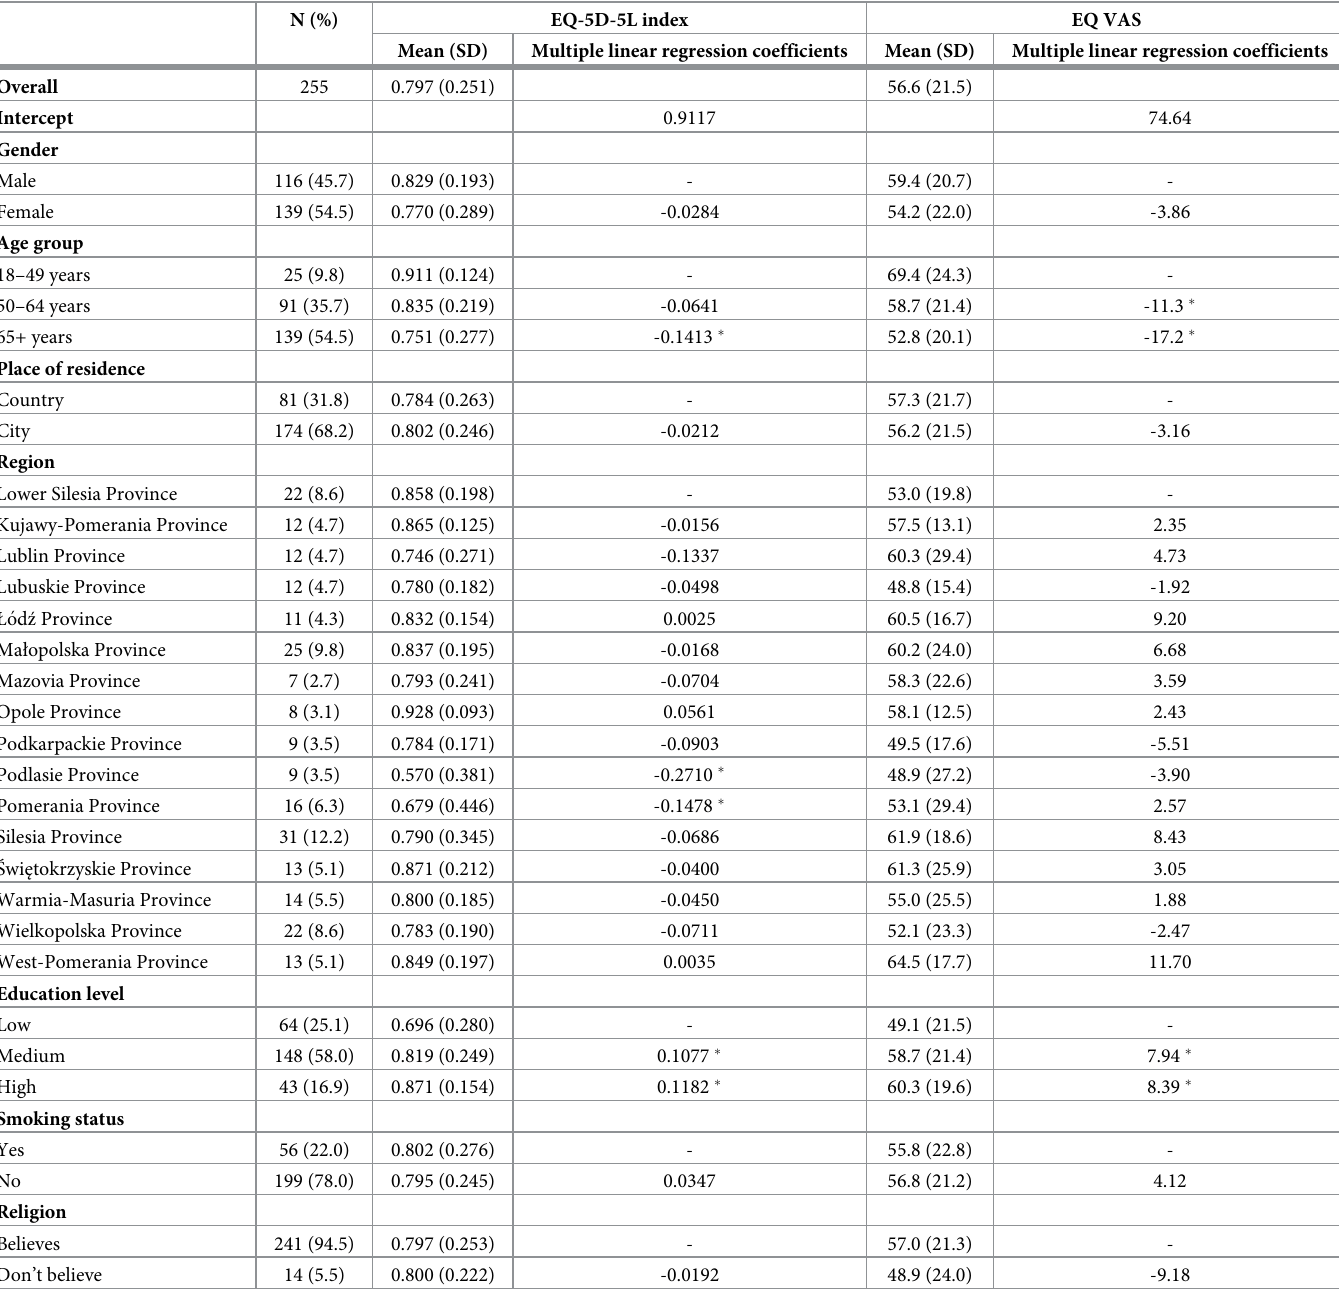
Table 5. Relation of EQ-5D-5L index and EQ VAS with demographic characteristics of diabetes patients (n =